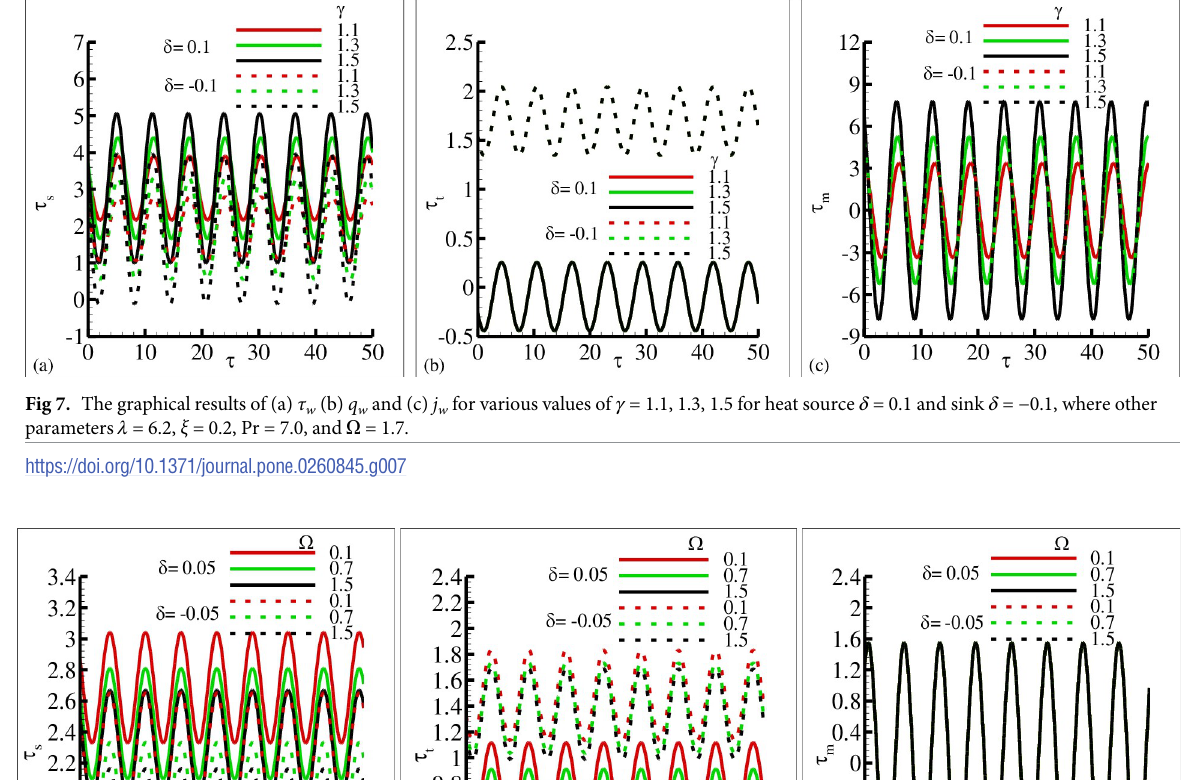
(b) q and (c) j for various values of O = 0.1, 0.7, 1.5 for heat source δ = 0.05 and sink δ = − 0.05, where other w w w